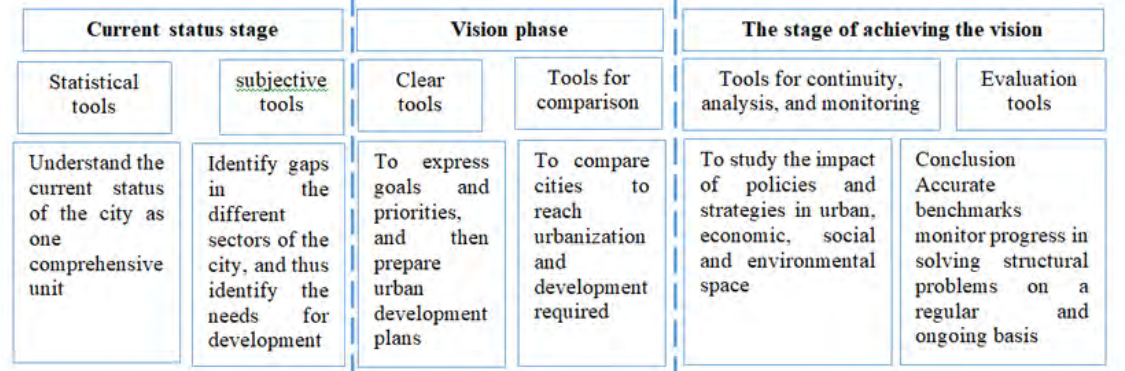
Figure 8. Proposed quality of life indicators